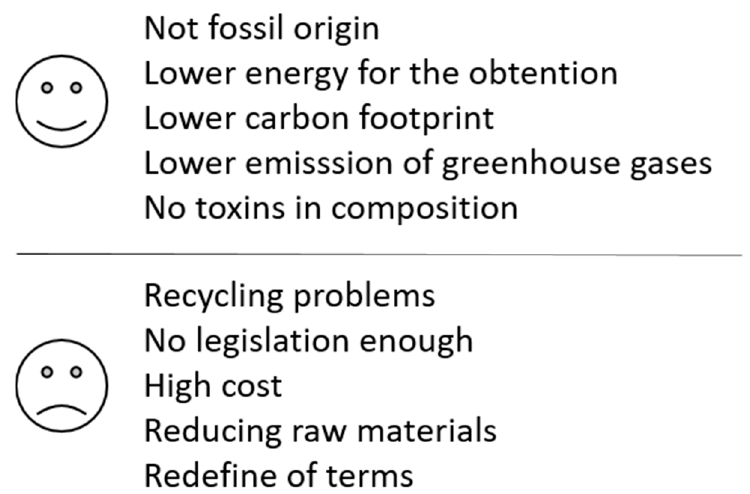
Figure 2. Advantages and drawbacks of bio-based materials [17].